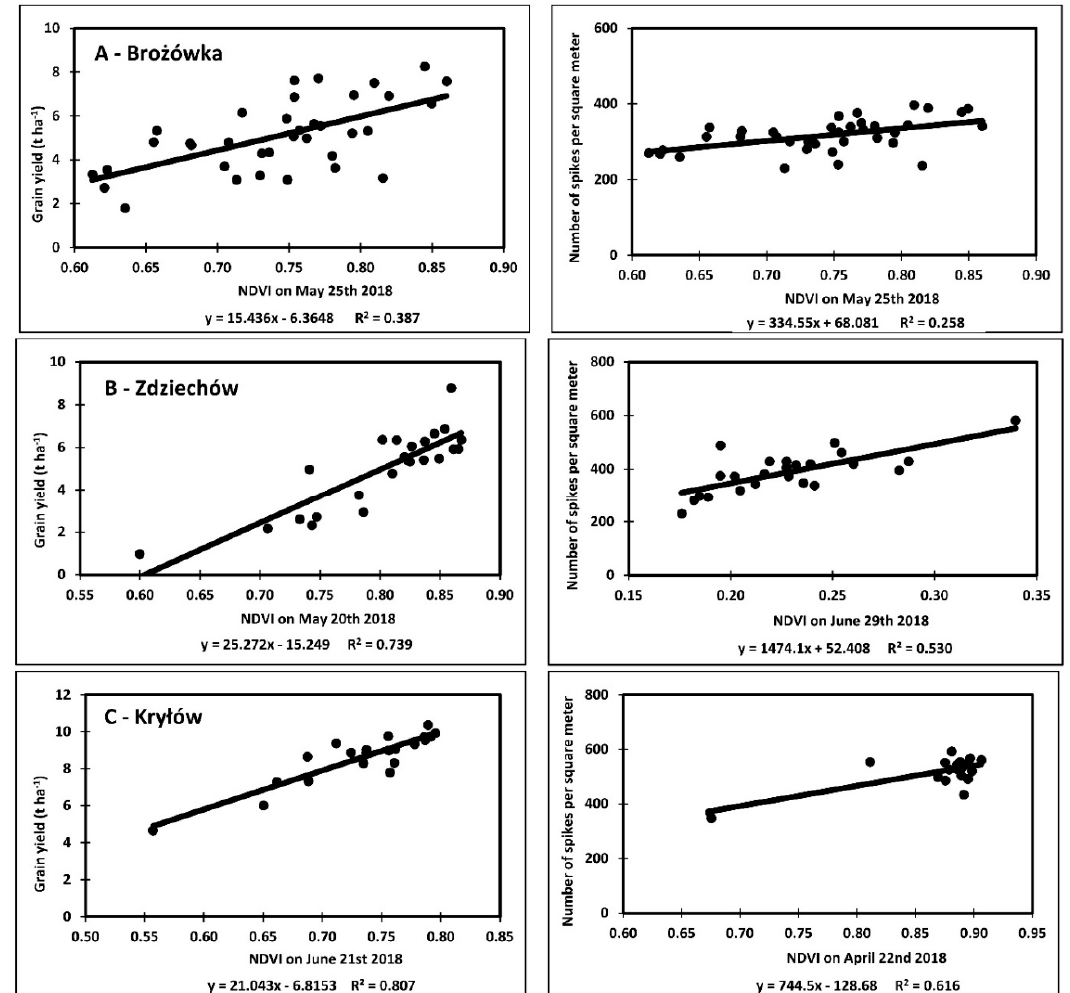
Figure 6. Relationships between grain yield (charts in the left side), number of spikes per square meter (charts in the right side) versus NDVI for three locations (A—Bro ż ówka, B—Zdziechów, C—Kry ł ów) for the date when their correlations reached maximum values in 2018. Regression equations and the value of the R 2 coefficient are given for each relationship.